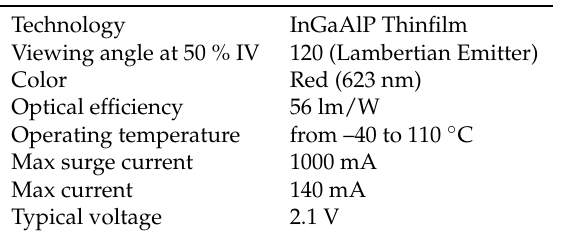
Table 3. Parameters of LED - LA